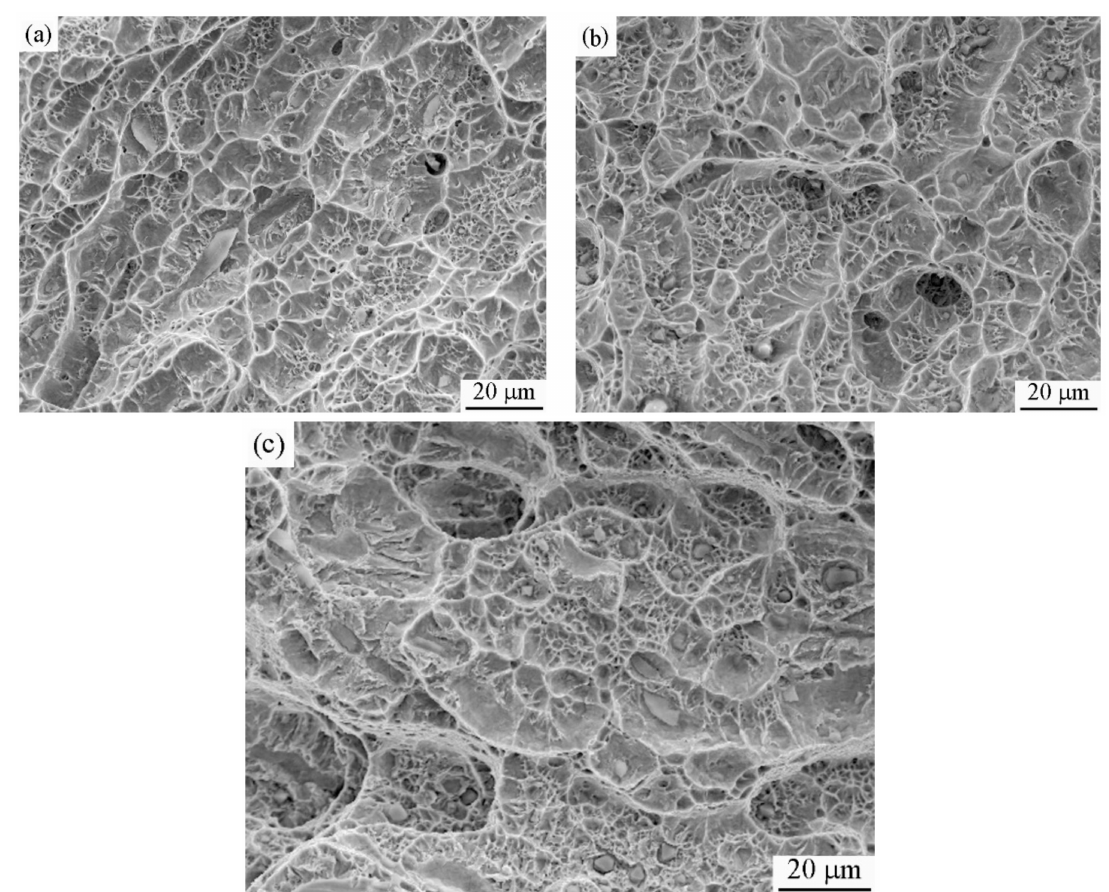
Figure 7. Tensile fracture surfaces: ( a ) Inconel 718 base metal, ( b ) Inconel 600 base metal, ( c ) Inconel 718/Inconel 600 dissimilar friction